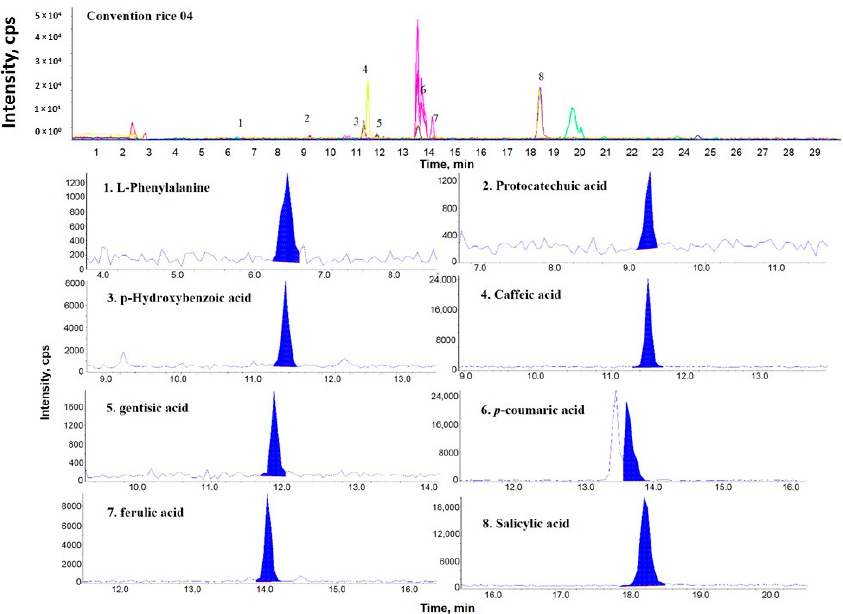
Figure 2. Representative MRM ion chromatogram of conventional rice (CR)-04 and the corresponding extracted ion chromatograms of the detected phenolic compounds.